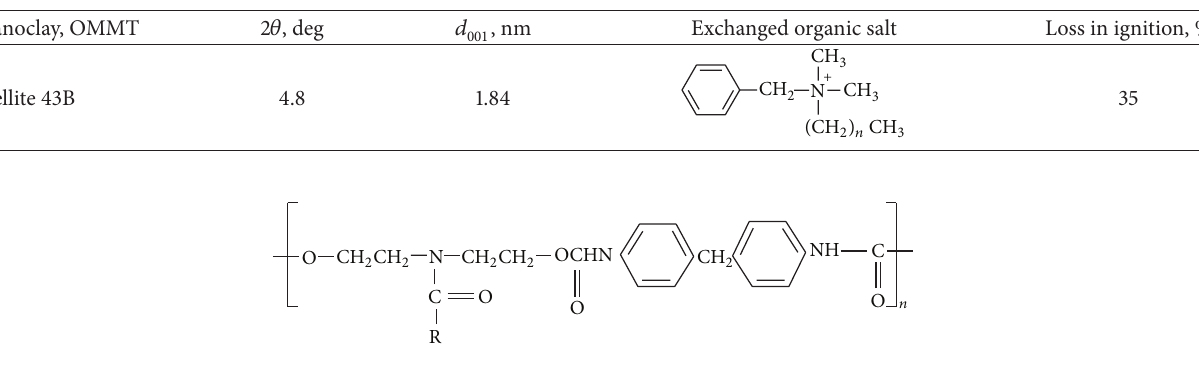
Figure 3: Structure of the synthesized